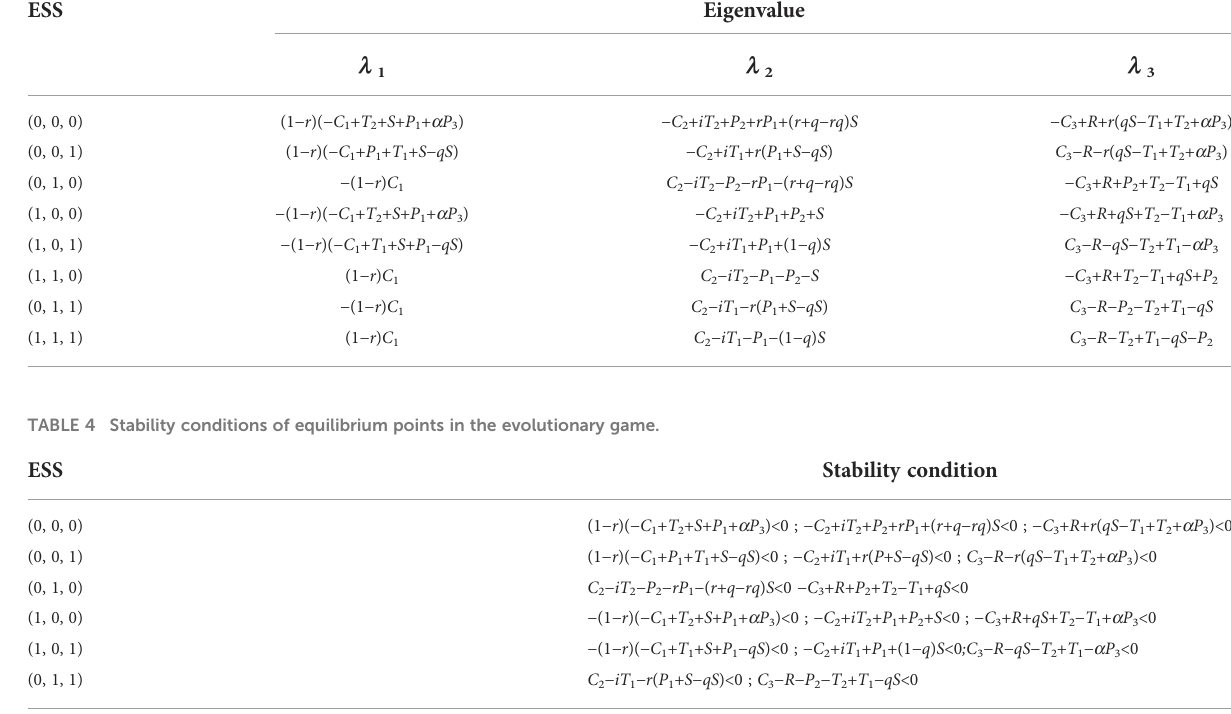
TABLE 3 ESS and eigenvalues of the dynamic